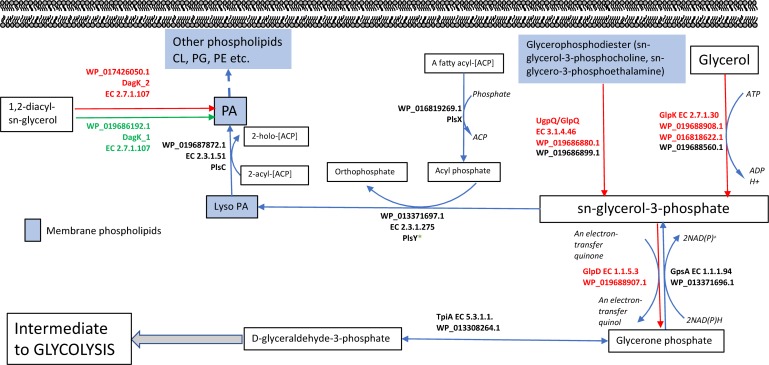
Metabolic fate of sn-glycerol-3-phosphate (sn-G3P): All the enzymes shown were measured by LC-MS/MS. sn-G3P (central molecule) is the precursor for synthesis of glycerophospholipids. 1,2 diacyl-sn-glycerol can also form lysoPA that ultimately forms PA. Two DagK enzymes responsible for forming lysoPA are significantly upregulated with several folds in swimming and swarming condition. sn-G3P can also be formed from glycerophosphodiester and proteins responsible for this step are specific for swarming activity suggesting a constant and active turnaround of sn-G3P from phosphodiester. sn-G3P is also a key intermediate of glycolysis. The red-colored enzymes and arrows are significantly higher in abundance in swarming motility, green-colored enzymes and arrows are significantly highly abundant in swimming motility and black color enzymes indicate that these enzymes were detected using MS but no significant difference in protein abundance in both motilities.